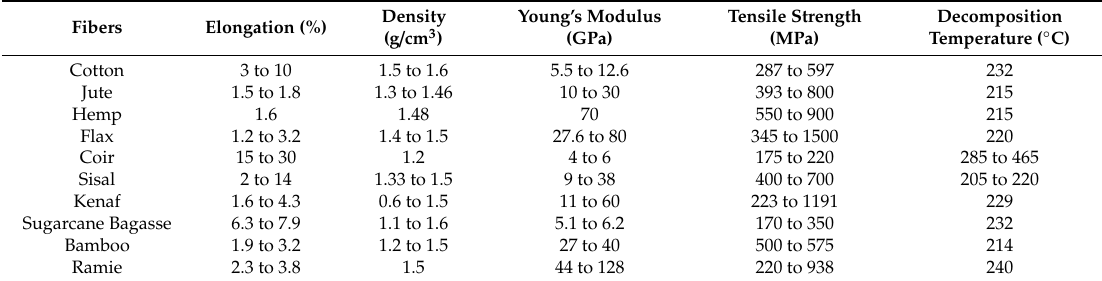
Table 3. Typical properties of some selected natural fibers